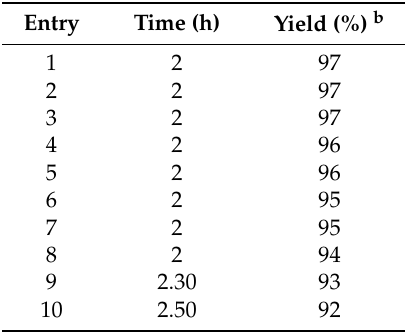
Table 5. Reusability study for synthesis of chromene derivatives a using HUC catalyst.